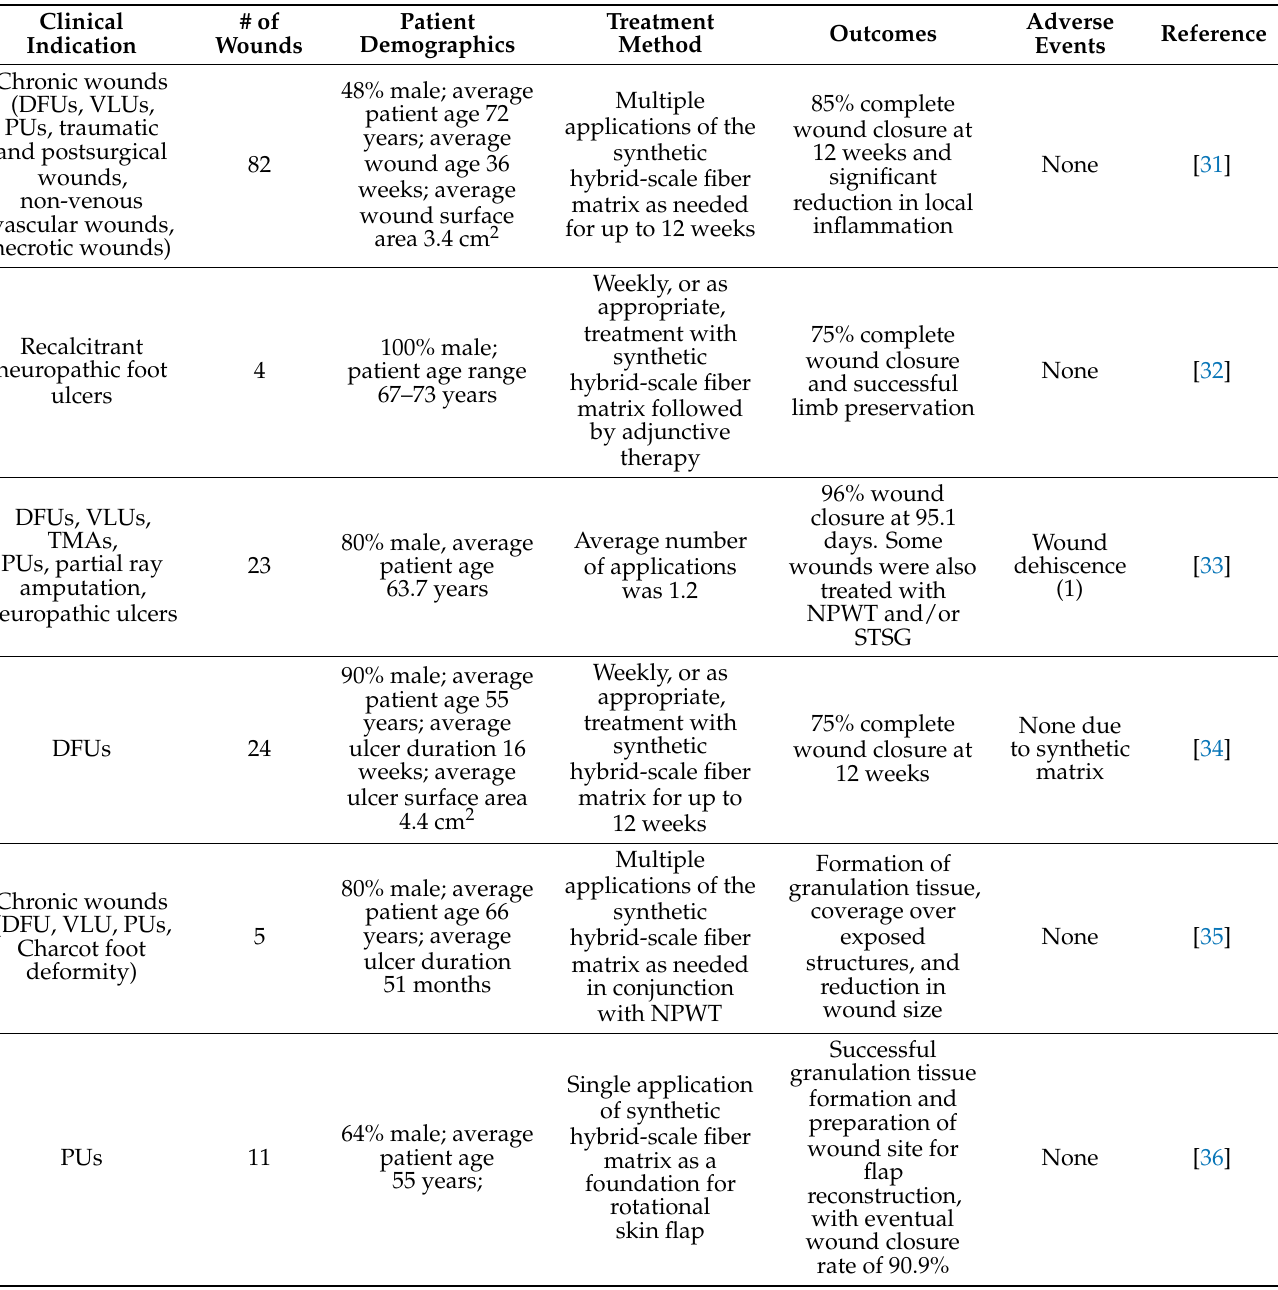
Table 2. Summary of clinical outcomes using the synthetic hybrid-scale fiber